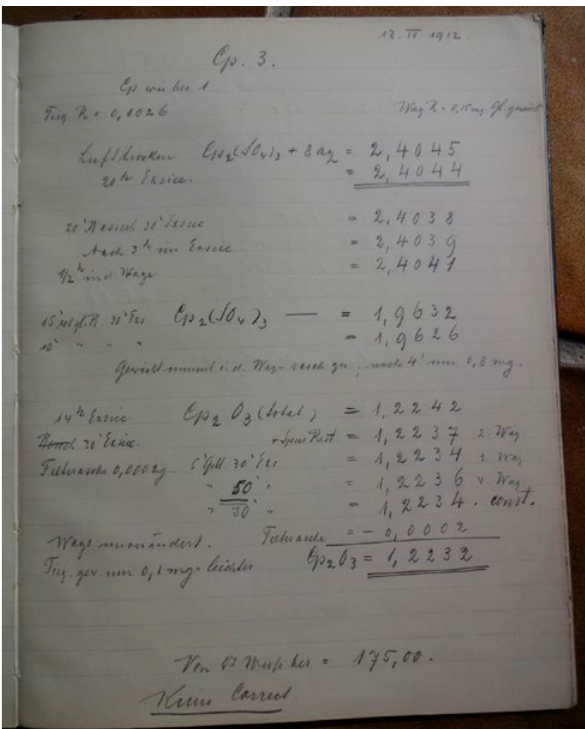
Figure 10. Lutetium (Cp), atomic weight determination 1912 (last step).